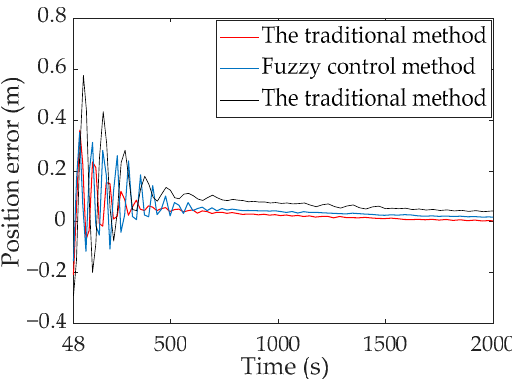
Figure 17. ( a ). Path-tracking results for Archimedean spiral. ( b ) Partial enlargement for the track- ing path.